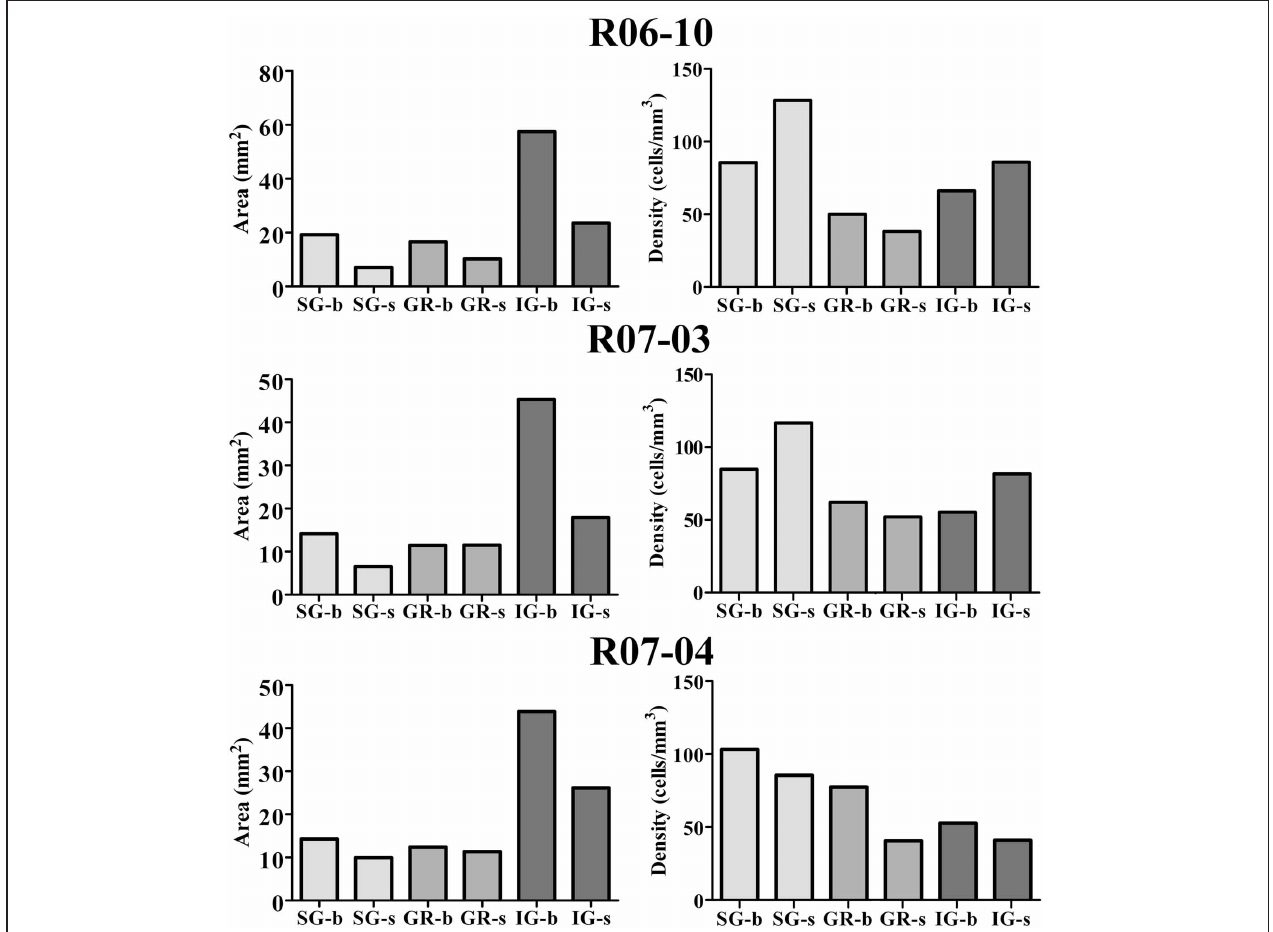
FIGURE 6 | Cortical compartment area ( left column ) and corresponding nitrergic neuronal density ( right column ) in the three hemispheres studied. Area measurements were estimated after summing up values obtained in all histological sections obtained in a given hemisphere. Likewise, density was calculated after counting the total number of cell bodies in the same sections. The infragranular layers (IG) correspond to 60% of S1. Barrel columns also correspond to 60% or more of S1.